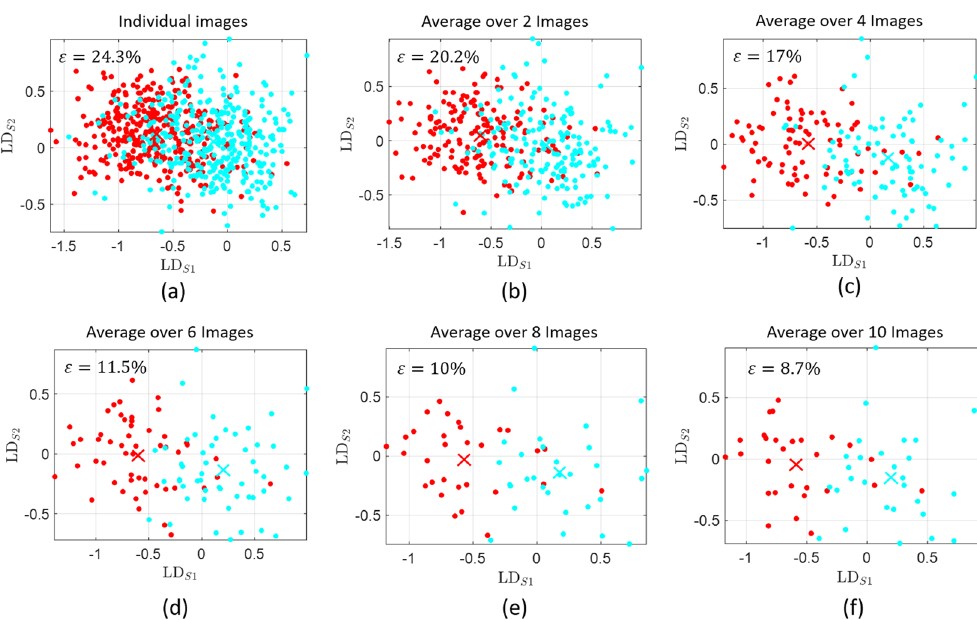
Figure 3. The effect of averaging separate images from the same volunteer and the same physiological state, on the final discrimination outcome. In ( a ) individual images with no averaging are used for the discrimination process. The accuracy of this approach is 75.7%. The accuracy increases noticeably with increasing the number of averaging images in ( b – f ). As shown previously in Fig. 2d,3, all images (usually ten to twelve) taken per volunteer per condition are averaged and the accuracy has considerably increased to 95%. An optimised training exercise was undertaken for each separate